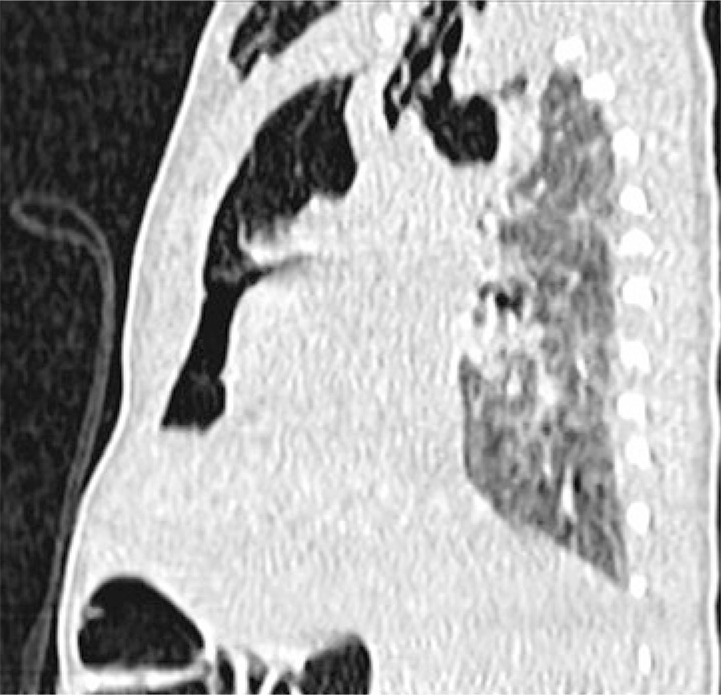
Tomografia computorizada que mostra enfisema subcutâneo e extenso pneumomediastino com discreta septação, sem alterações do parênquima pulmonar (corte sagital)